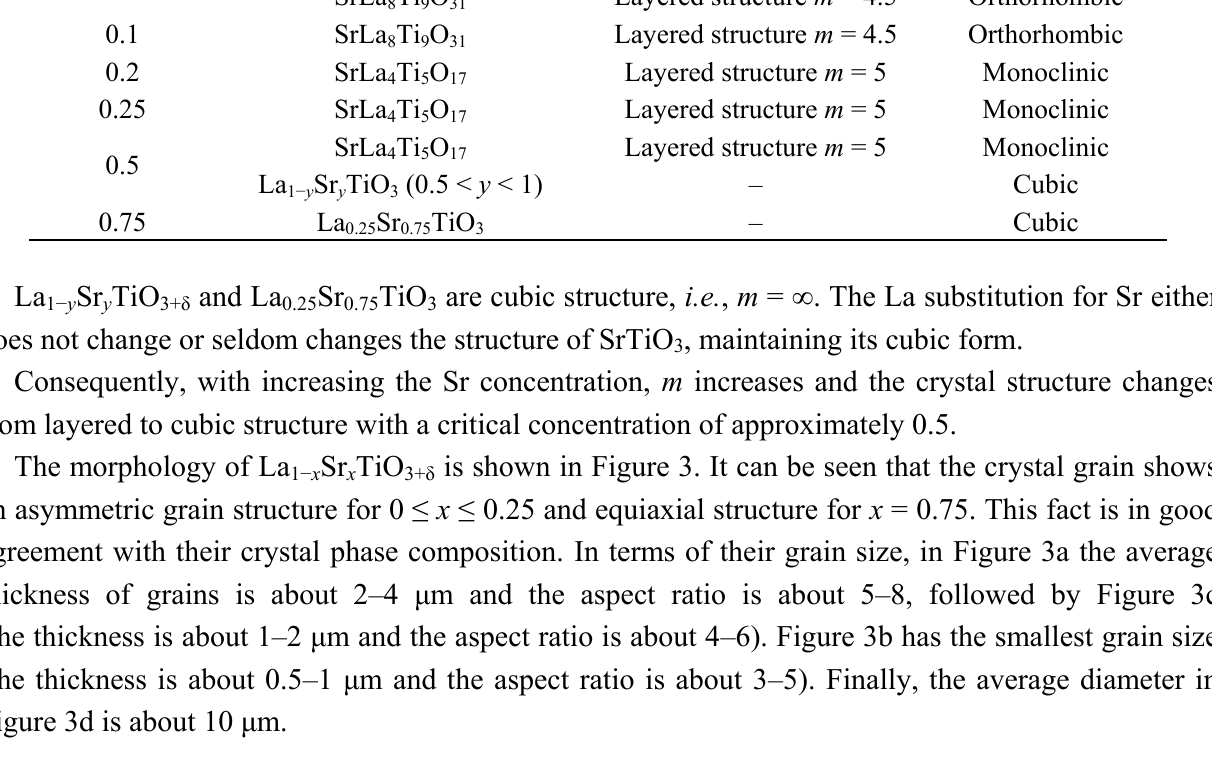
Table 2. Phases and crystal structures of La